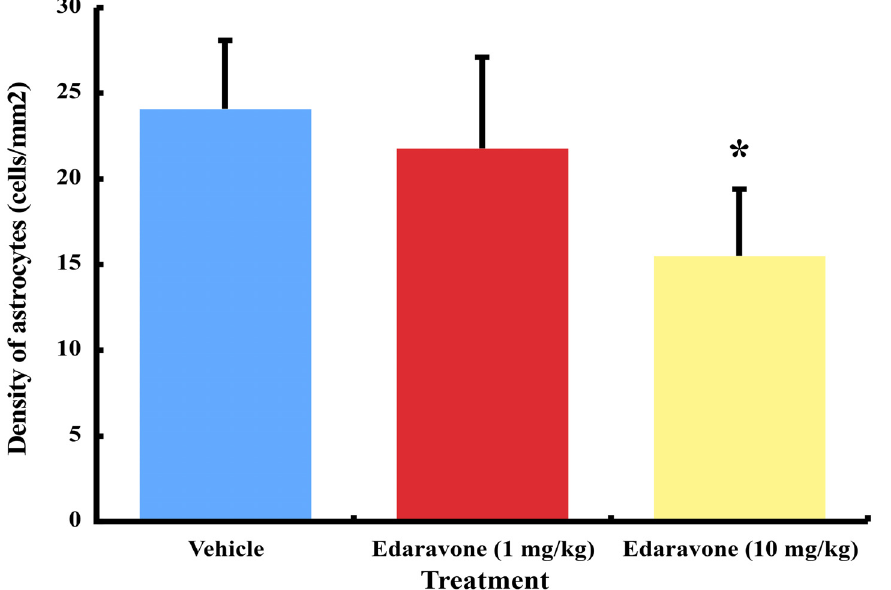
Fig 4. The astrocyte density of the ventral spinal cord in edaravone- and vehicle-treated wobbler mice. Mice treated with higher dose of edaravone decreased the density of GFAP-immunoreactive astrocytes significantly compared to vehicle. * P < 0.05, the higher dose of edaravone group versus the vehicle group by one-way ANOVA and Dunnett multiple comparison test. Results are represented as the mean ± SEM (n = 10/group).